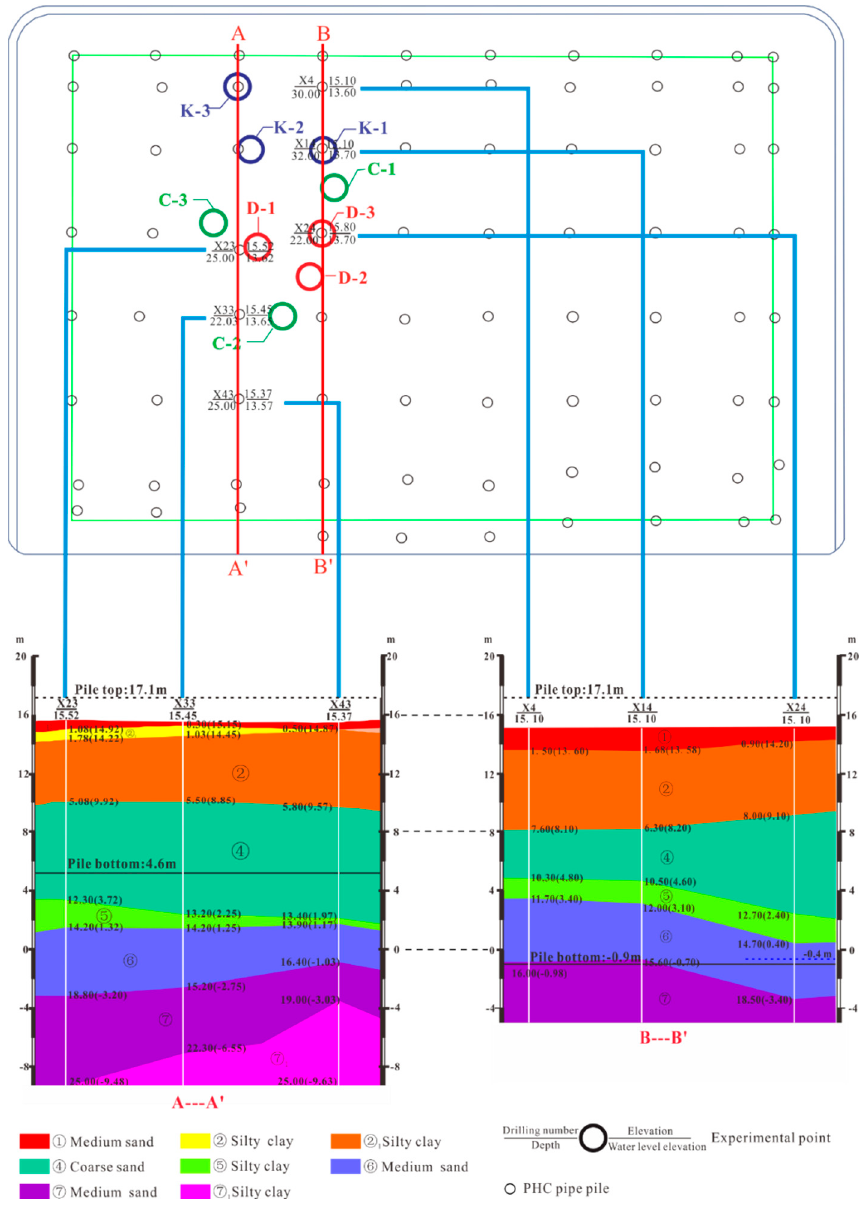
Figure 1. Schematic diagram of plant area and geological cross-section with the exploratory boreholes.